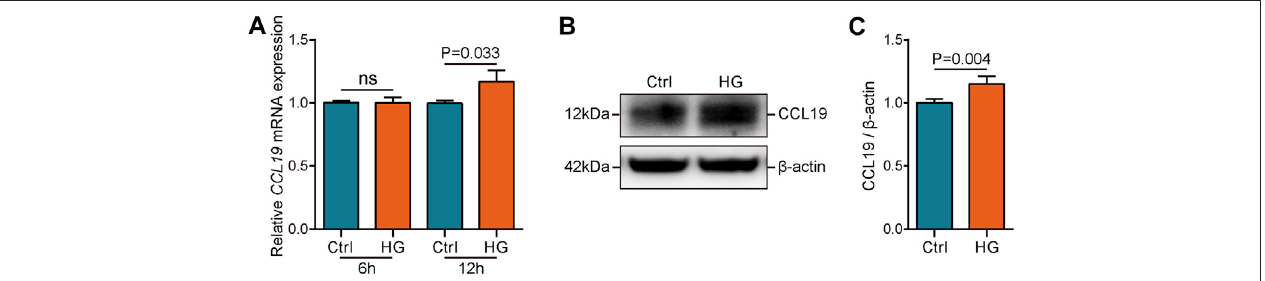
FIGURE 6 | Validation of CCL19 using in vivo experiment. (A) mRNA level of CCL19 under high glucose stimulation was analyzed by qPCR. (B,C) Protein level of CCL19 under high glucose stimulation was analyzed by western